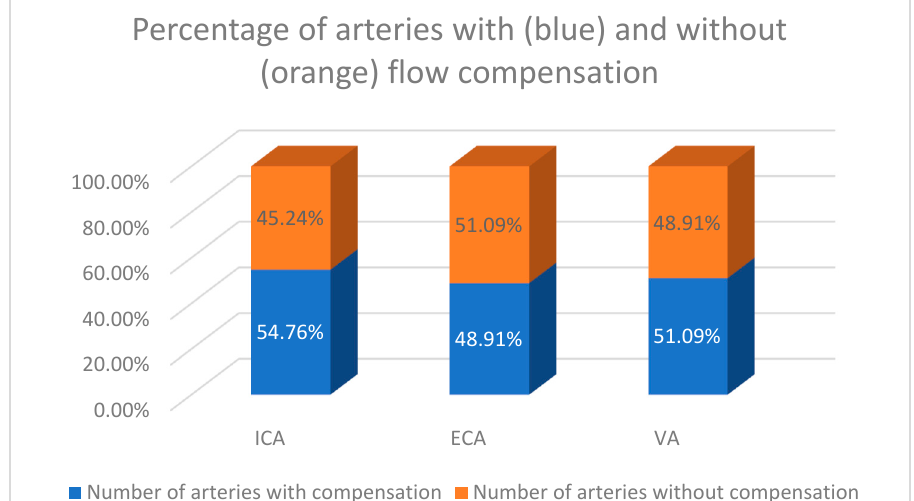
Figure 3. The percentage of patent arteries with and without flow compensation. The compensatory increased flow volume was most frequently observed in the contralateral ICA—54.76%, in 48.91% of ECAs, and in the 51.09% of